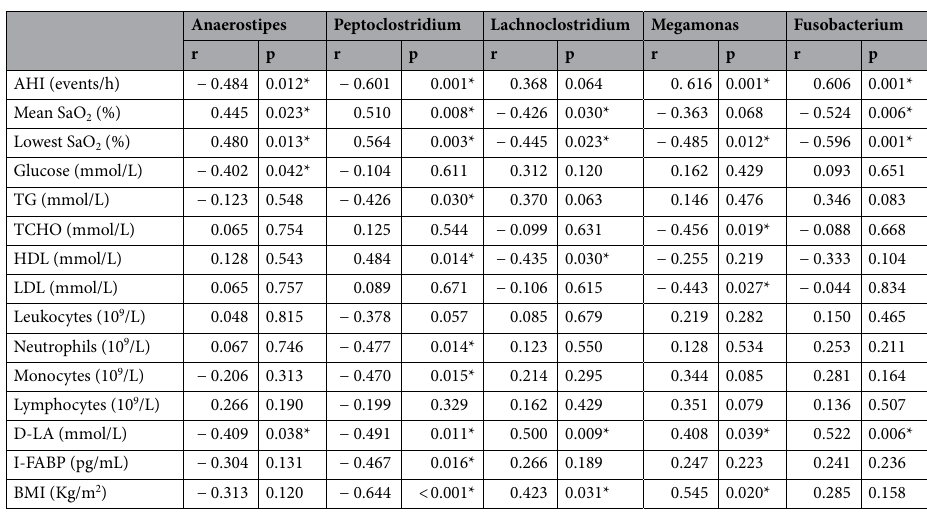
Table 2. Correlation analysis of variables and microbiota characteristics of severe OSA. AHI, apnea hypoventilation index; M-SaO 2 , Mean pulse oxygen saturation; L-SaO 2 , Lowest pulse oxygen saturation; Glucose, fasting blood sugar; TG, triglycerides; TCHO, total cholesterol; HDL, high density lipoprotein; LDL, low-density lipoprotein; Leukocytes, white blood cell count; Neutrophils, neutrophil count; Monocytes, mononuclear cell count; Lymphocytes, lymphocyte count; D-LA, D-lactic acid; I-FABP, intestinal fatty acid- binding protein; BMI, body mass index. p values based on Spearman analysis. *P < 0.05, the difference is statistically significant.